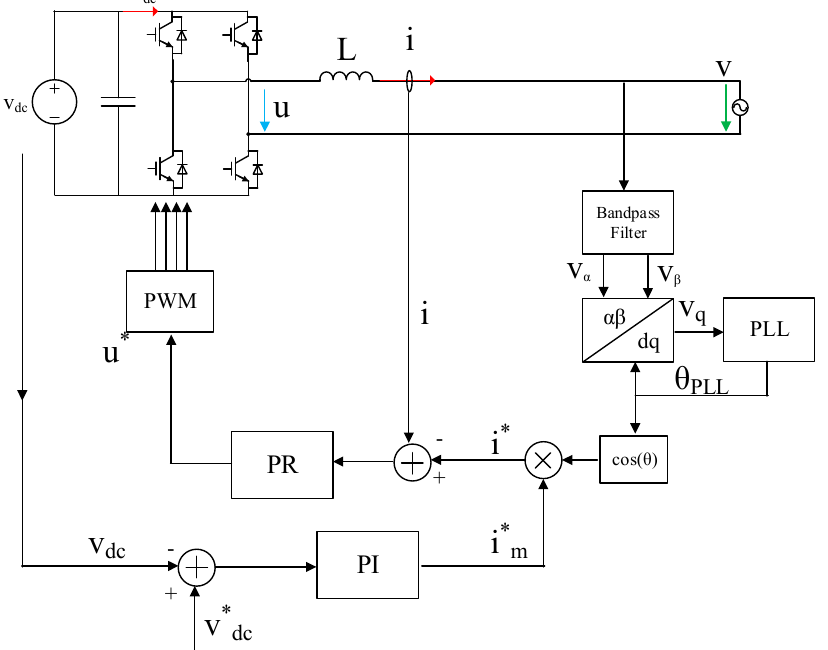
Figure 5. The block diagram of a typical PR (proportional resonance) based current control inverter.